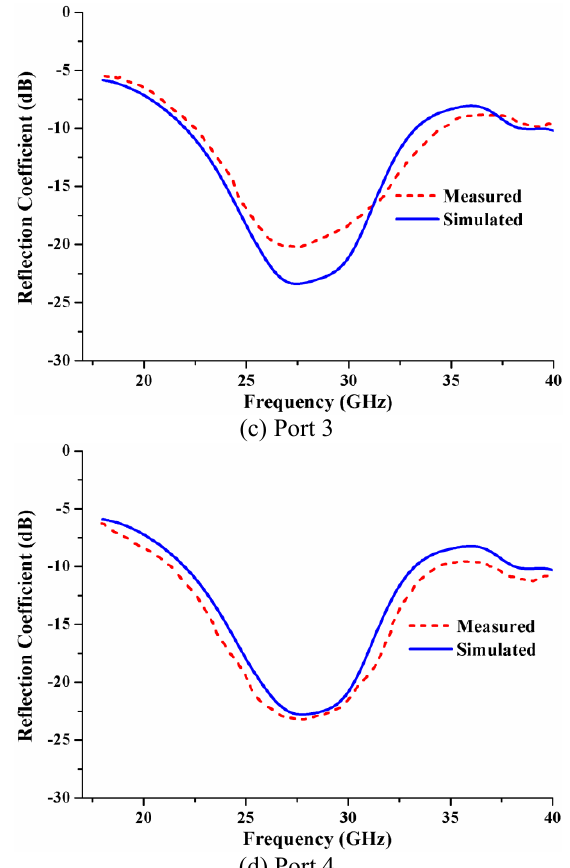
Figure 7: Simulated and Measured Reflection coefficients of proposed reconfigurable antenna when fed through different ports The simulated and measured 2D polar cuts in azimuth and elevation planes depicting both co-polarization and cross- polarization for each port are shown in Fig. 8 and Fig. 9.